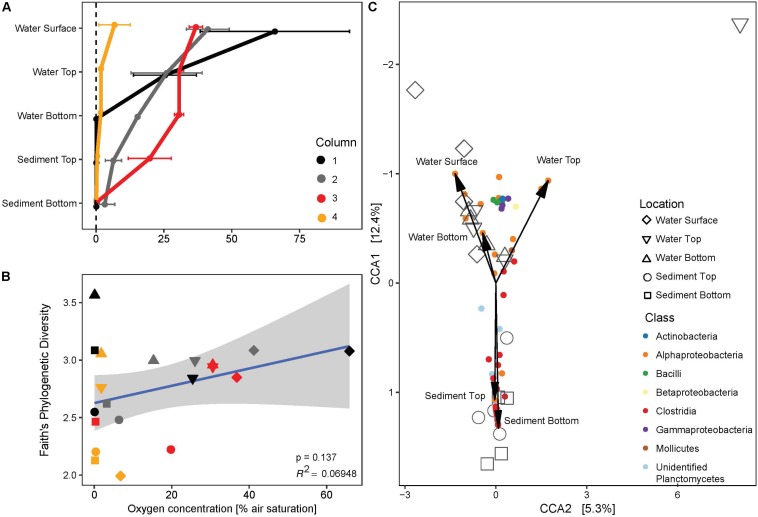
(A) Vertical profiles of dissolved oxygen concentration along the four replicate MiniColumns. (B) Regression analysis of phylogenetic diversity and oxygen concentration. Gray area marks 95% confidence region. Colors of symbols are as indicated in panel (A), whereas shapes indicate location in the column as indicated in the legend to panel (C). (C) CCA triplot of enriched bacterial communities (large symbols) in relation to bacterial OTUs that best explain the ordination (colored at Class level) and location in the MiniColumns (arrows).